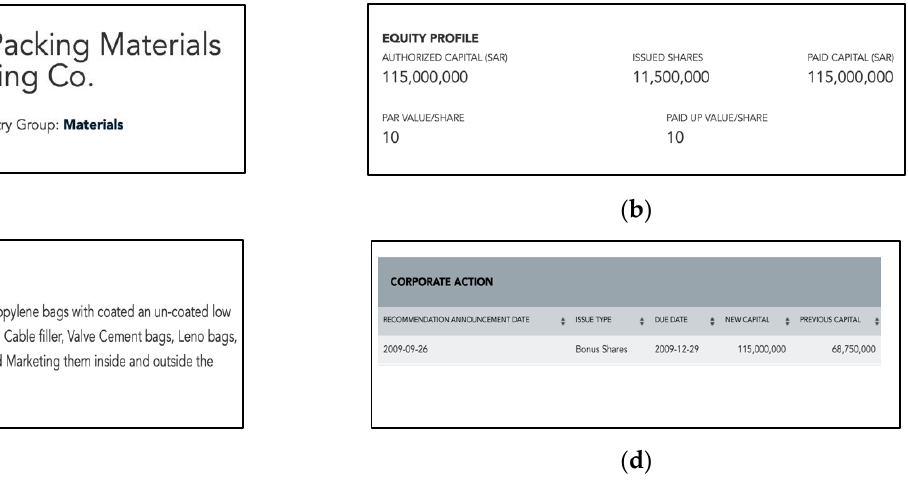
Figure 1. Samples of profile information that Tadawul has released for each stock symbol, including ( a ) company identification information, ( b ) equity profile, ( c ) company overview information, and ( d ) company capital-changes history.